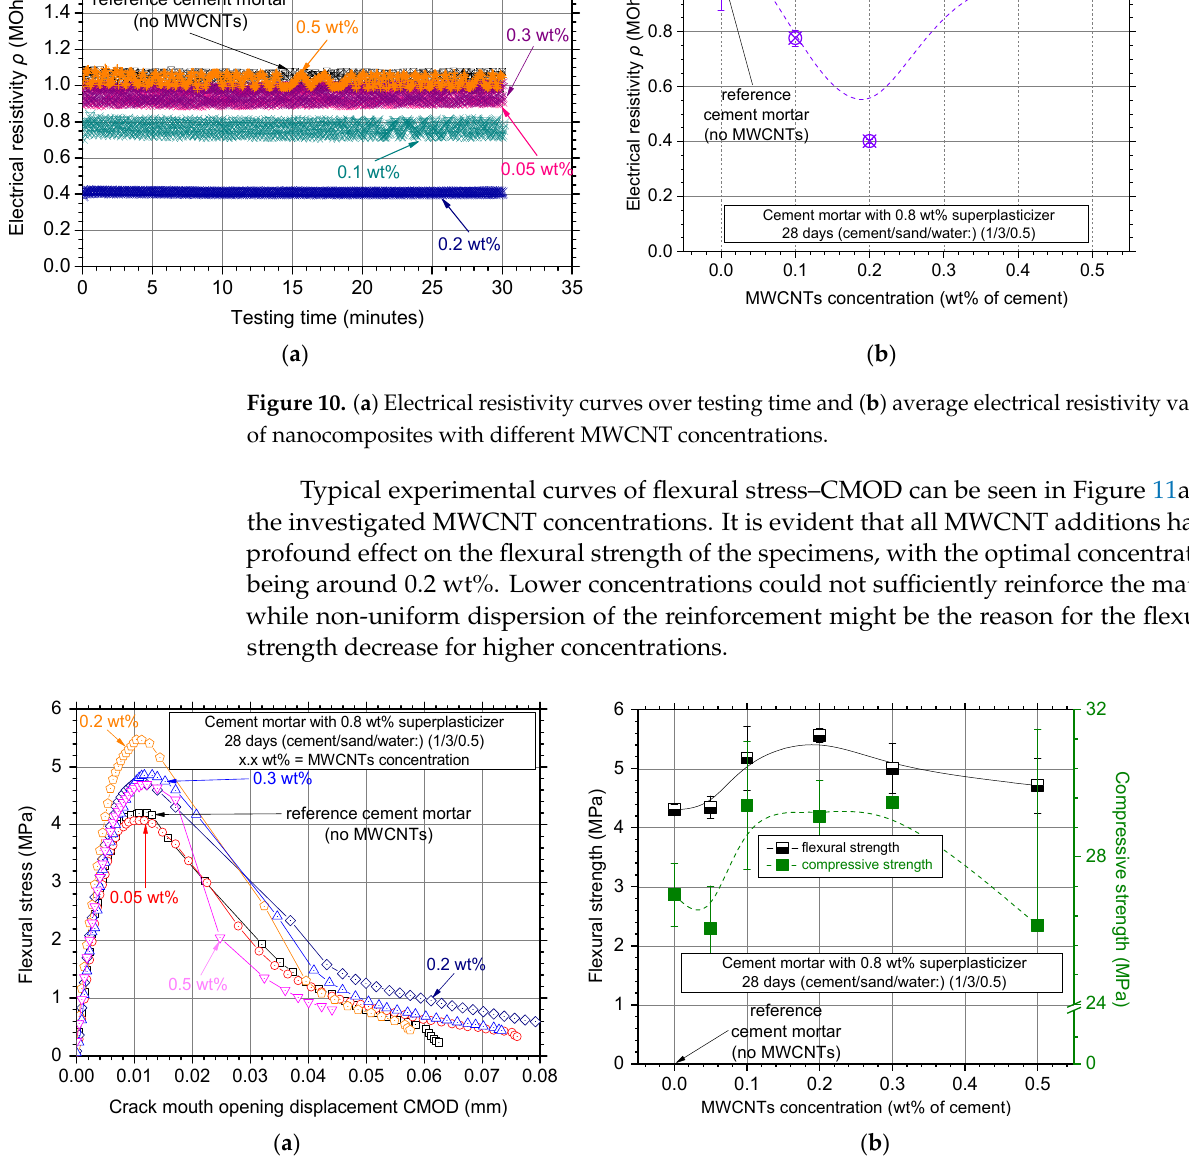
Figure 11. ( a ) Typical flexural stress–crack mouth opening displacement curves and ( b ) average flexural and compressive strength values and standard deviation of nanocomposites with different MWCNT concentrations. Figure 11b shows the flexural strength results of the investigated MWCNT concen ‐ trations in terms of average values and respective standard deviation. Concentrations of 0.1 and 0.3 wt% also exhibited high flexural strength values, nevertheless, high scatter (standard deviation) was observed. This might be due to the low reproducibility of the experiments due to the non ‐ uniform distribution of the MWCNTs. To this end, it seems that in terms of flexural strength results, the reinforcing concentration within the region of 0.1 up to 0.3 wt% essentially increased flexural strength, with 0.2 wt% being the optimal concentration for the maximum flexural strength. Compression tests results can also be